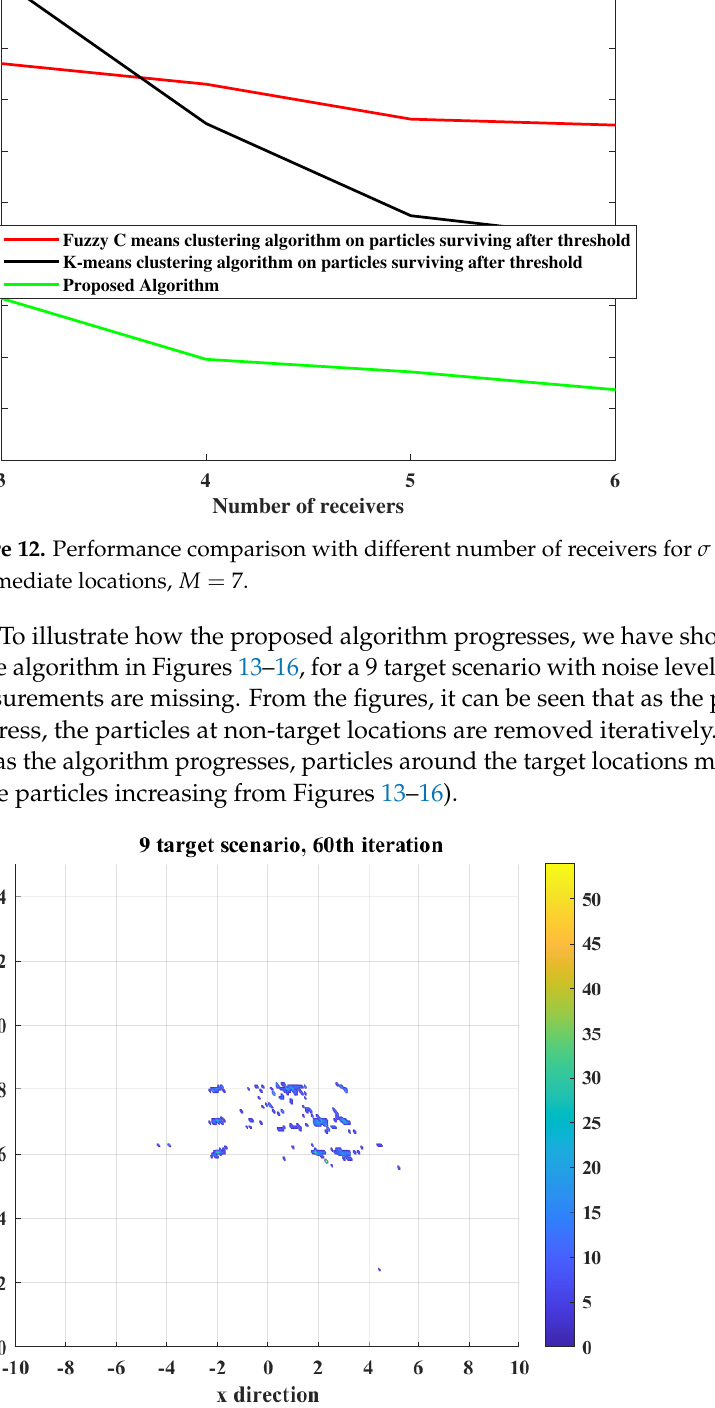
Figure 13. Surviving particles of the proposed algorithm at the end of 60th iteration. Mass of the particles is represented using the color. The simulation is performed for a 9 target scenario with 10% of missing measurements and with noise level σ = 0.1. The color scale indicates the mass of the